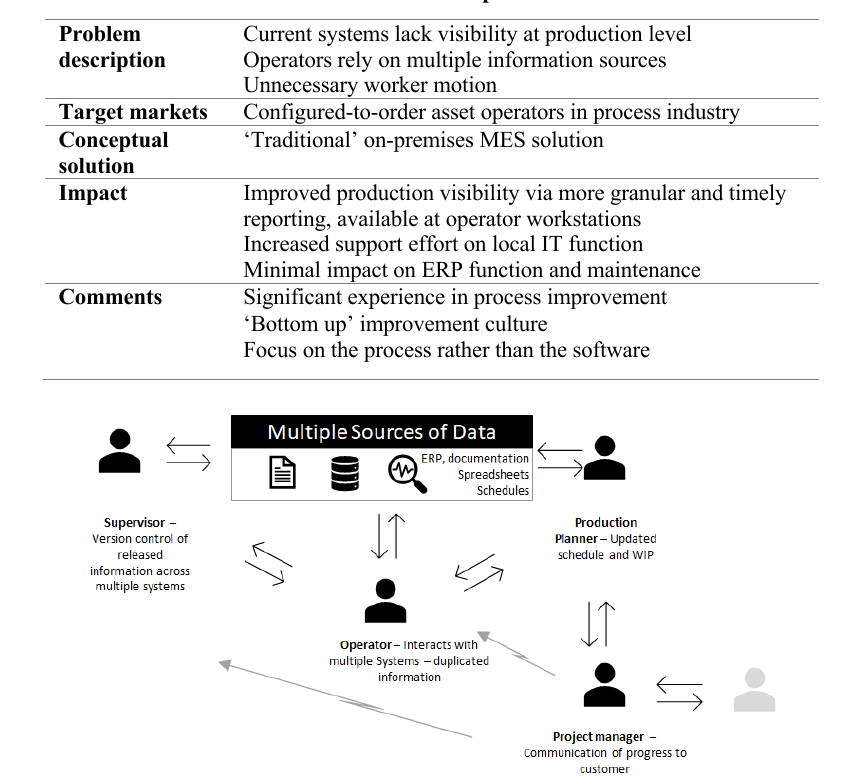
Fig. 1. Multiple resources of data and multiple actors within the